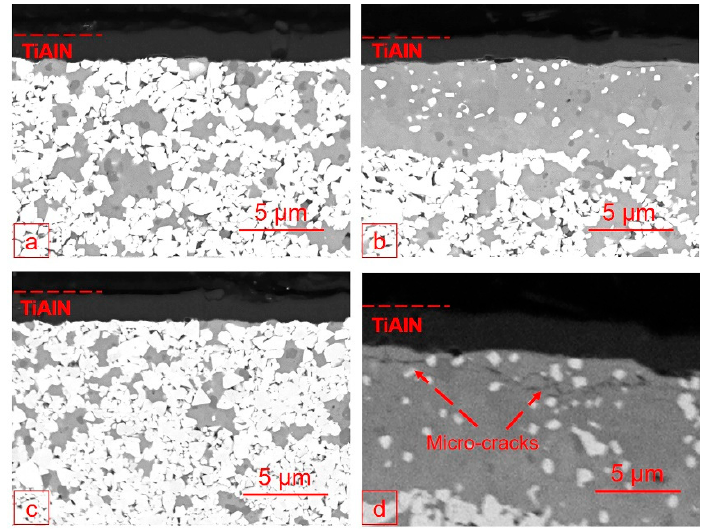
Figure 7. Cross-sectional microstructures of four coated cutters on FGC and conventional carbide substrates, ( a ) FC5-3, ( b ) FC5-4, ( c ) FN1-3, and ( d ) FN1-4.